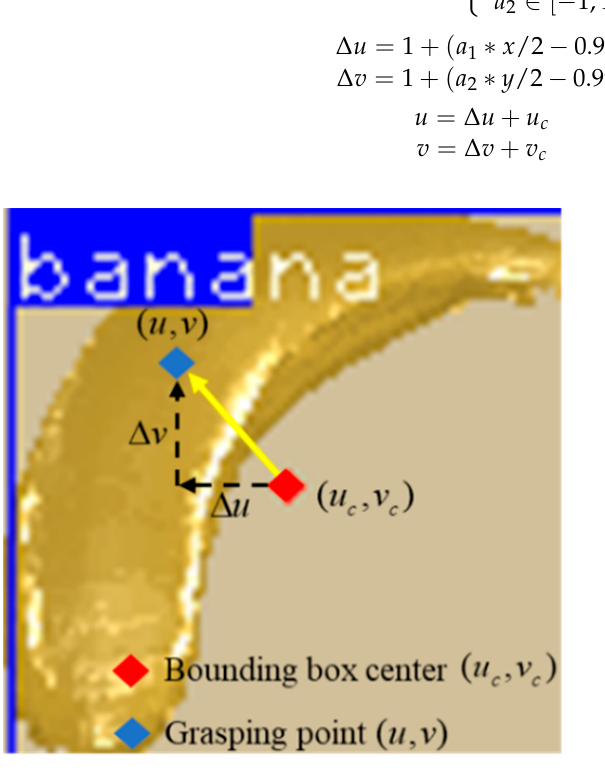
Figure 6. The displacement vector and the object grasping point on the image plane.